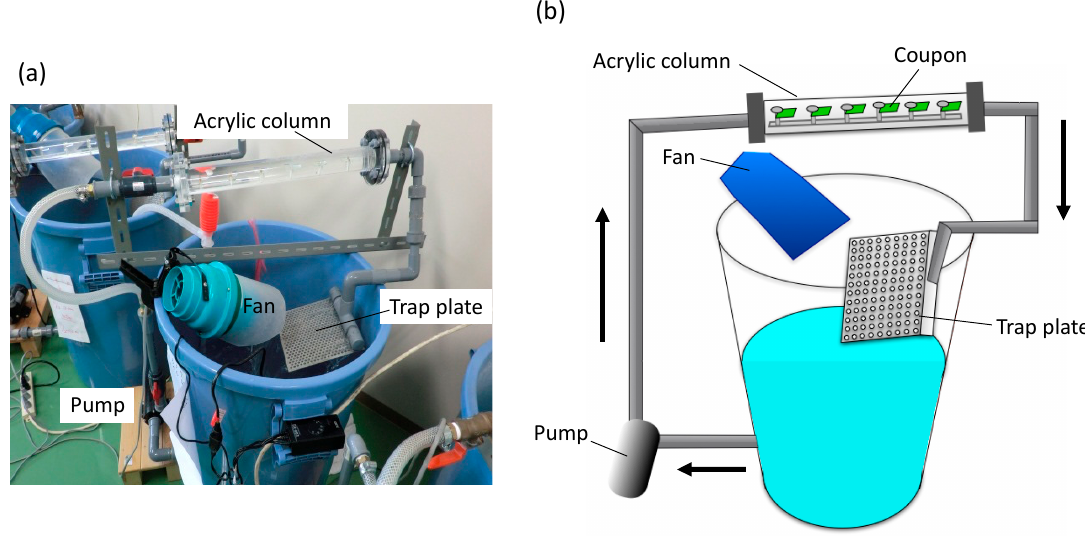
Figure 2. The laboratory biofilm reactor (LBR). ( a ) Photo image of the LBR. ( b ) The outline of the LBR. Arrows indicate water flow.